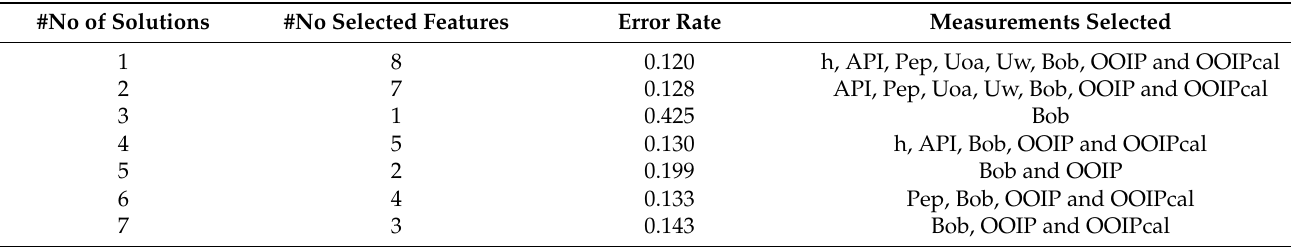
Figure 3. Non-dominated solutions obtained by MOGWO-ANN. Table 4. Results of the MOGWO-ANN.